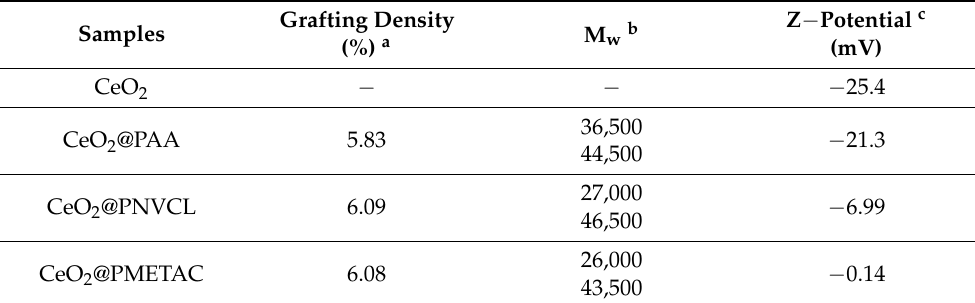
Table 1. Results for the z-potential, GPC, and TGA for the initial particles and the ones with the polymer brushes.